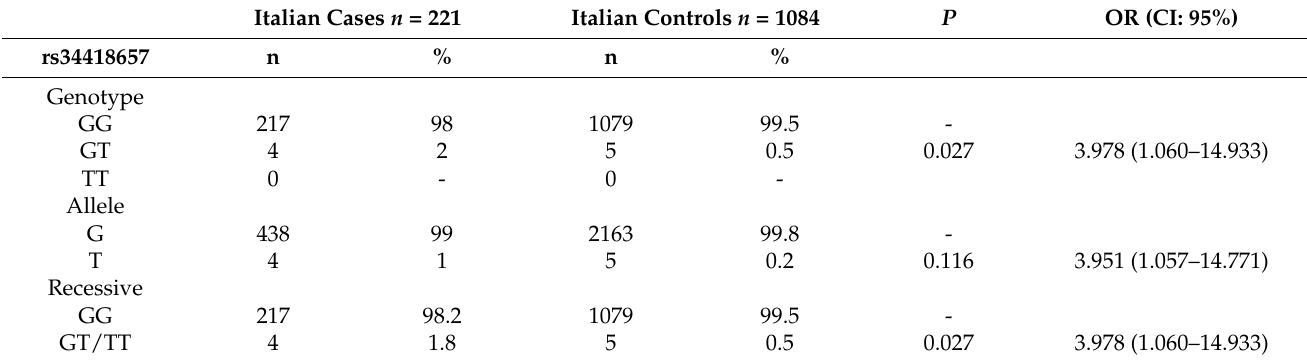
Table 3. Association of rare coding variant rs34418657 with severe COVID-19 in the Italian cohort. Italian Cases n =